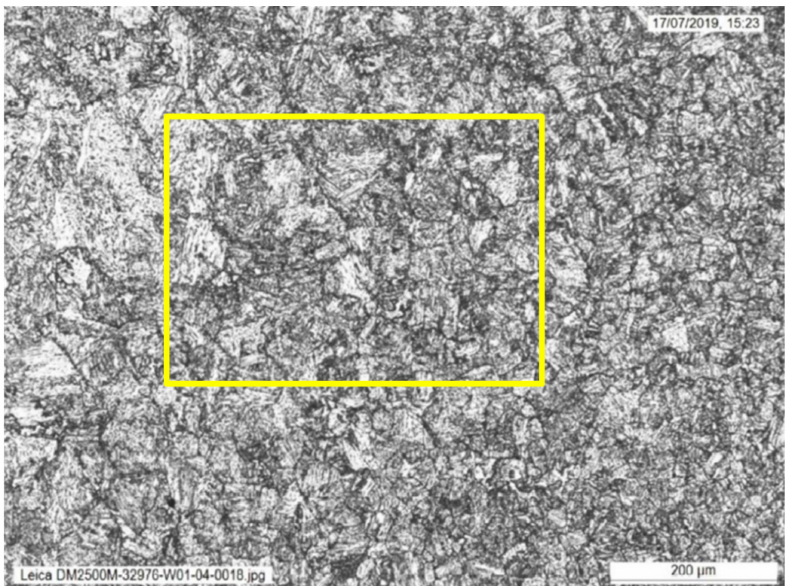
Figure 4. Microstructure in the location of the ICGCHAZ from Figure 2 at higher magnification, showing coarse grains decorated with second phase precipitates around the grain boundaries.